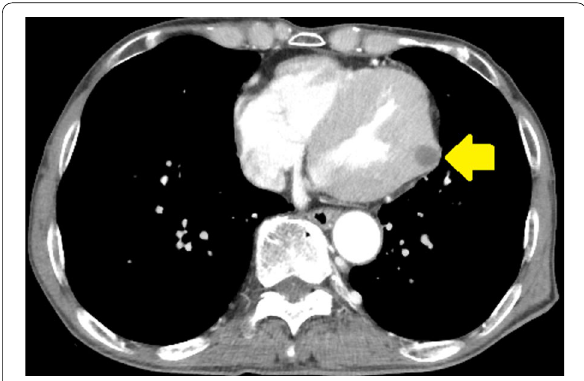
Fig. 2 Computed tomography of the chest showing a defect (11 11 mm in diameter) in the left ventricle (arrow) ×